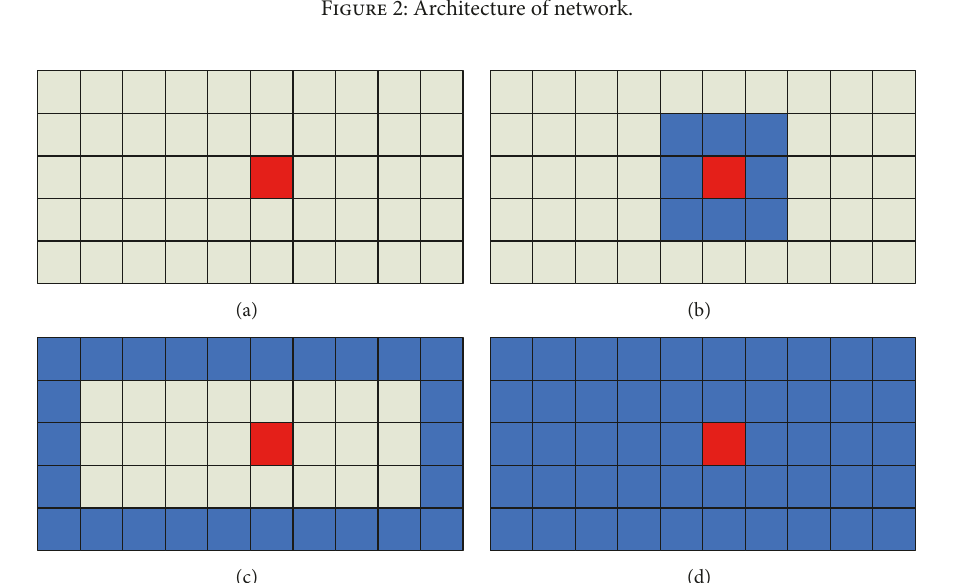
Figure 3: Four types of regions. (a) The red region denotes rectangle sample, (b) The blue regions denote neighborhoods of rectangle sample, (c) The blue regions denote boundaries of the image, (d) The blue regions denote image area except rectangle sample.